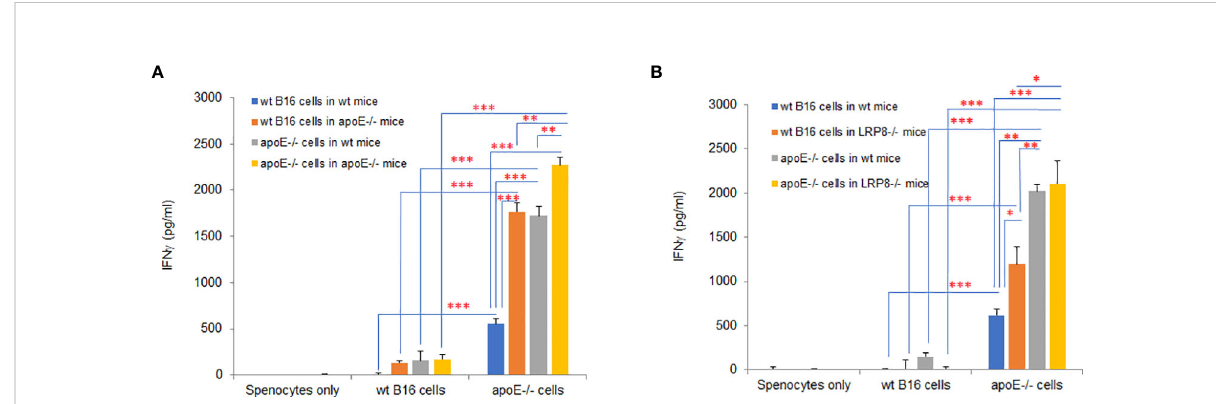
FIGURE 10 ApoE knock out in B16 tumor cells induces potent immunogenicity. Wild type and apoE -/- mice (A) or wild type and lrp8 -/- mice (B) , were inoculated with either WT B16 or apoE -/- cells, with anti-CTLA4 antibody on day 0. Splenocytes were harvested on day 7 and co-cultured with either WT B16 or apoE -/- B16 cells for 48hr, following which IFN g levels in media were compared with ELISA assay. Results show that IFN g production is highest for all groups when apoE -/- cells are used. These fi ndings re-iterate the potent inhibitory effect of apoE on immune cell activation in the cancer environment. Results are expressed as mean score ± SD. *p<0.05; **p<0.005; ***p<0.001, determined by unpaired two-tailed Student ’ s